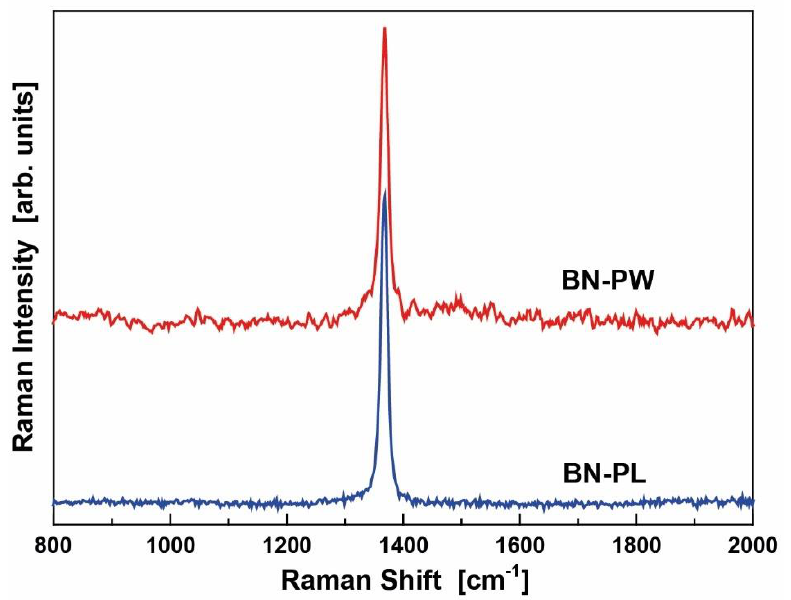
Figure 5. Raman spectra of BN powder and platelets.